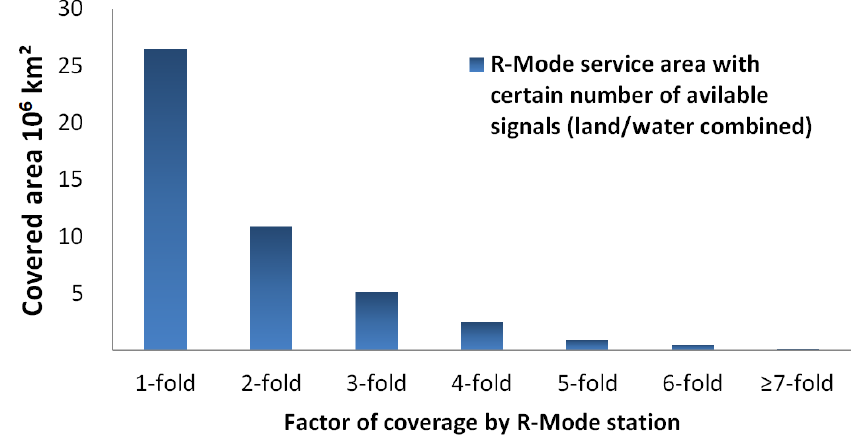
Figure 4. Single and multiple covered areas with potential Medium Frequency (MF) R-Mode sig- nals.